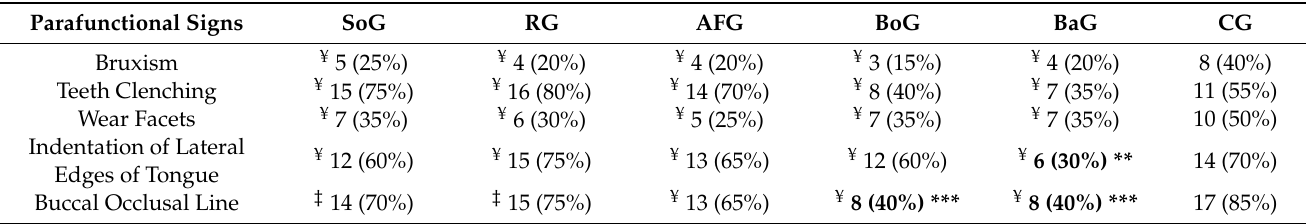
Table 7. Parafunctional signs: comparison between different sports and controls.